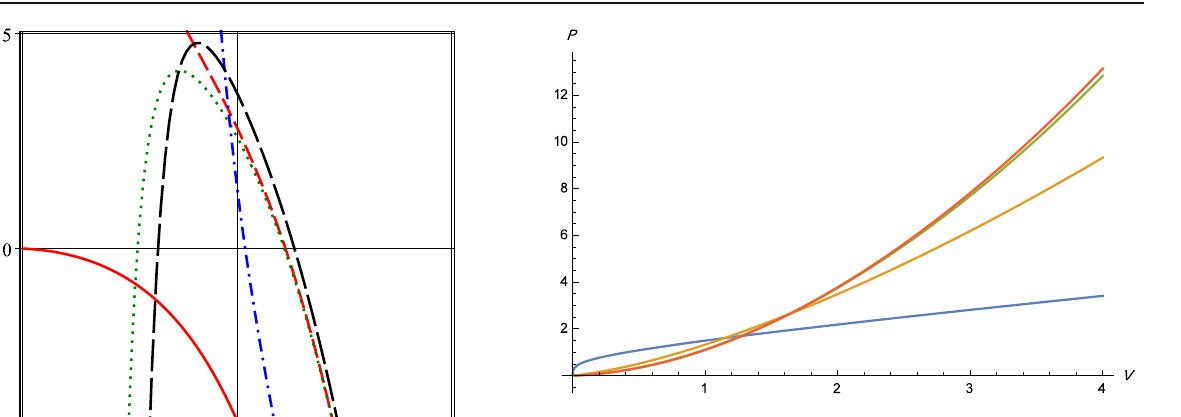
Fig. 4 P–V diagram for the hyperscaling-violating geometry for d = 2 , 3 , 8 and 9, showing different behaviors for d = 2 from the other dimensions. We set α = 0 . 5 and γ 1 = γ 2 =